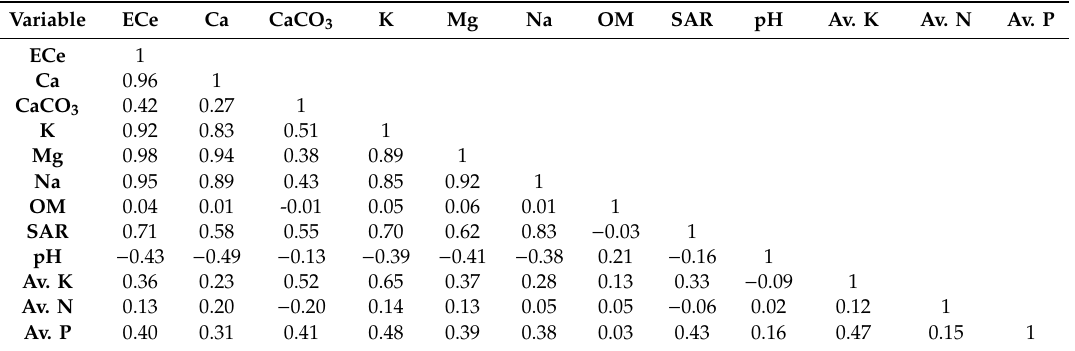
Table 2. Correlation coe ffi cients of the soil